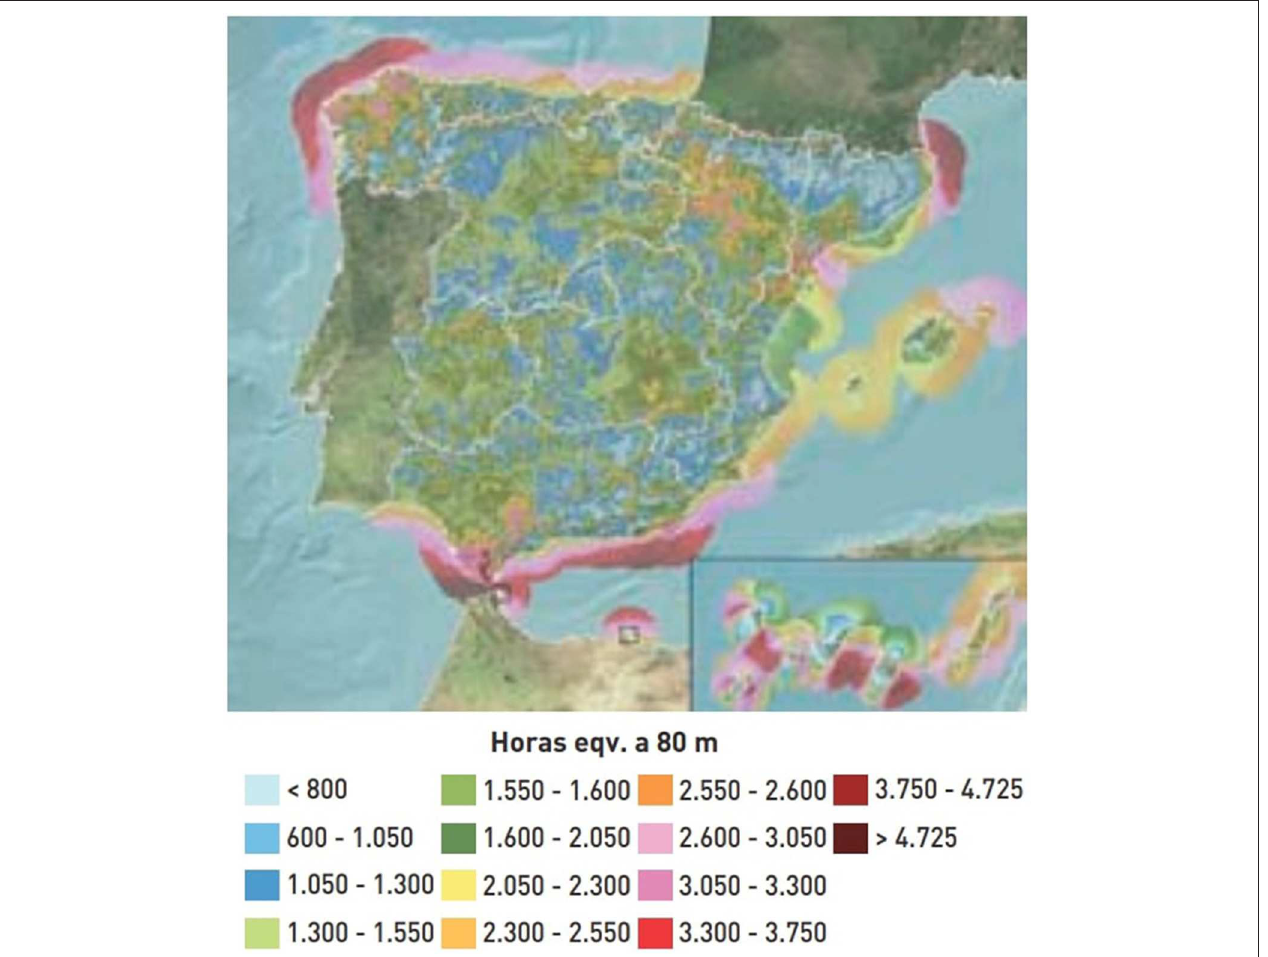
FIGURE 13 | Number of equivalent hours with full performance per year. Reproduced from IDEA.